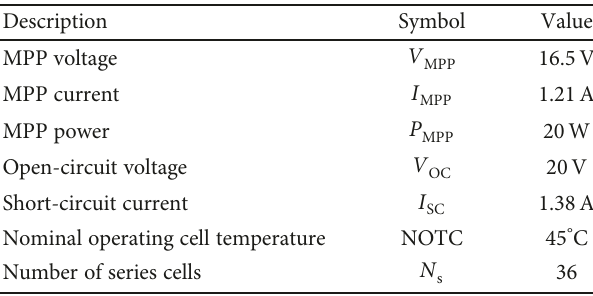
Table 1: Main electrical characteristics of the adopted Photonsolar PM0020 [39]